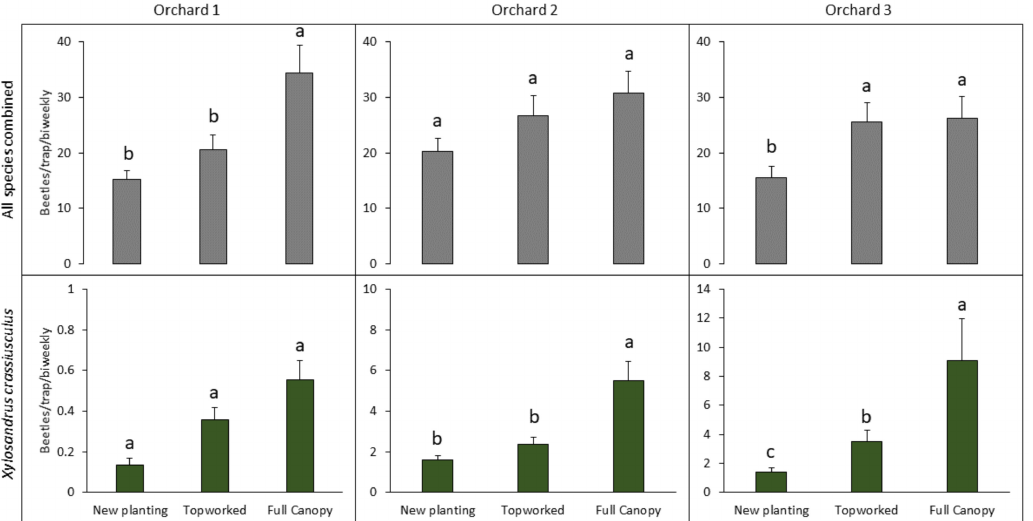
Figure 2. Average ( ± SEM) captures of all ambrosia beetle species combined (top row) and Xylosan- drus crassiusculus (bottom row) in three commercial avocado orchards with laurel wilt over a one-year period. Error bars with the same letters are not significantly different (Tukey HSD; α = 0.05). (Note different scales on the y-axis).